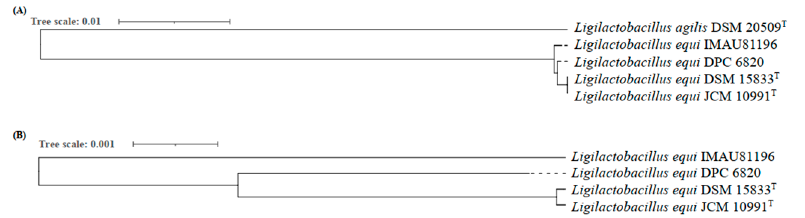
Figure 2. ( A ) Phylogenetic relationship among four strains of L. equi based on 247 core gene L. agilis DSM 20509 as outgroup and ( B ) phylogenetic relationship among four strains of L. equi based on 1454 core genes.